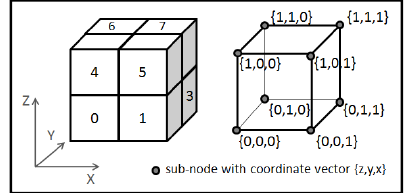
Figure 7. Numbering and coordinates of sub-nodes